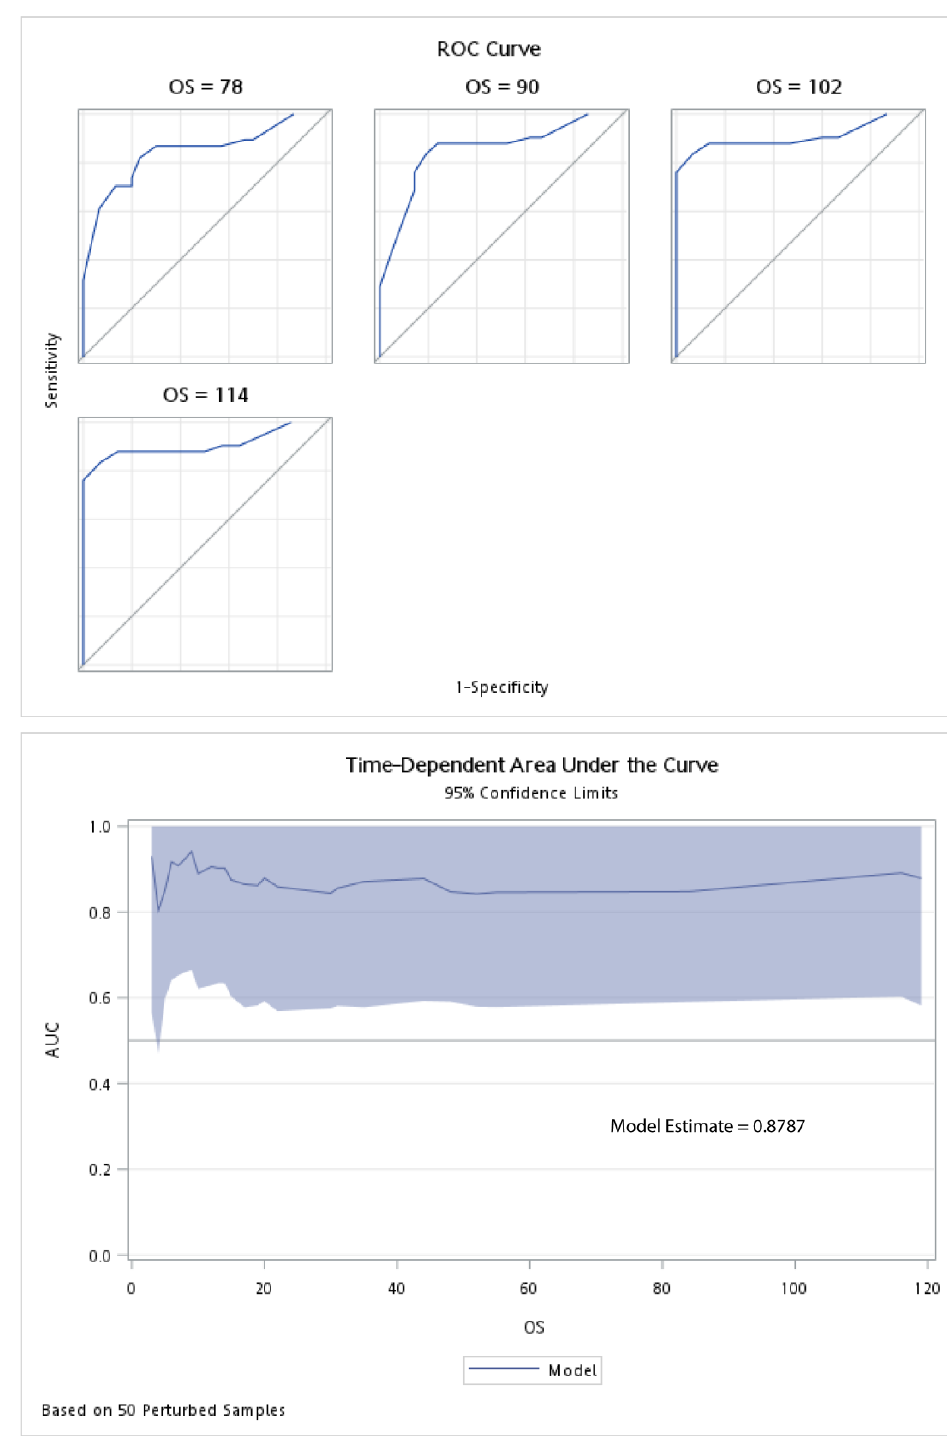
Figure 2. Harrell’s concordance statistics and time-dependent area under the curve for the overall survival (OS) in the pre- and post-treatment model.